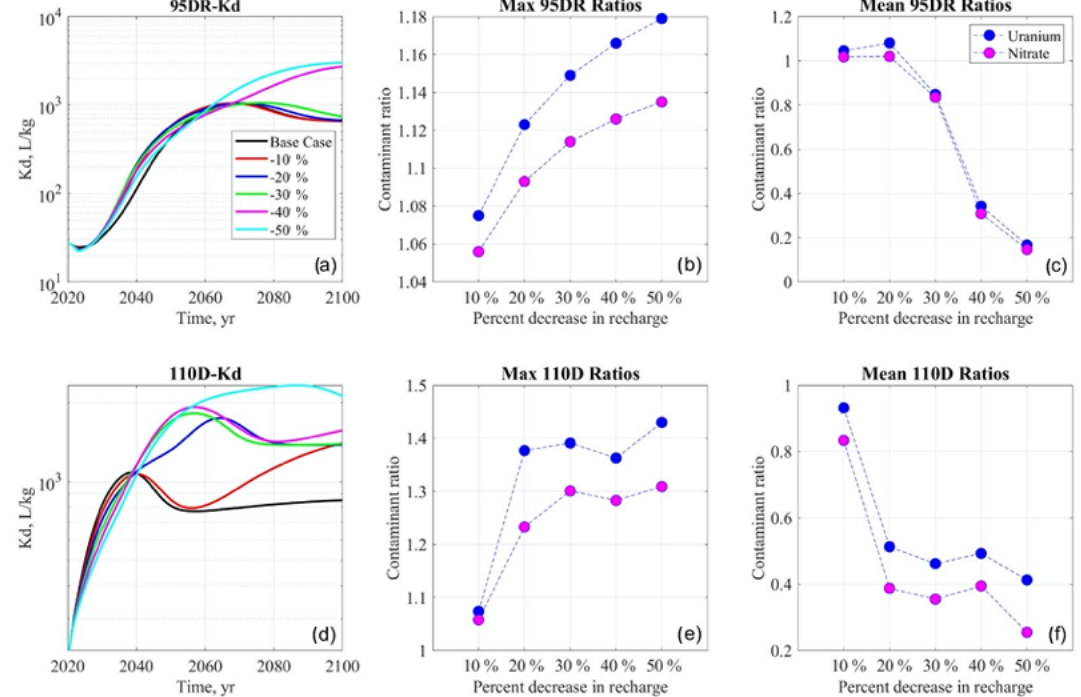
Figure 9. Breakthrough curves for K d at the source-zone well (a–c) and the downgradient well (d–f) for the increasing recharge scenario from 2020 to 2100. Maximum and average ratios of base case to increased recharge case for uranium and nitrate concentrations at both well